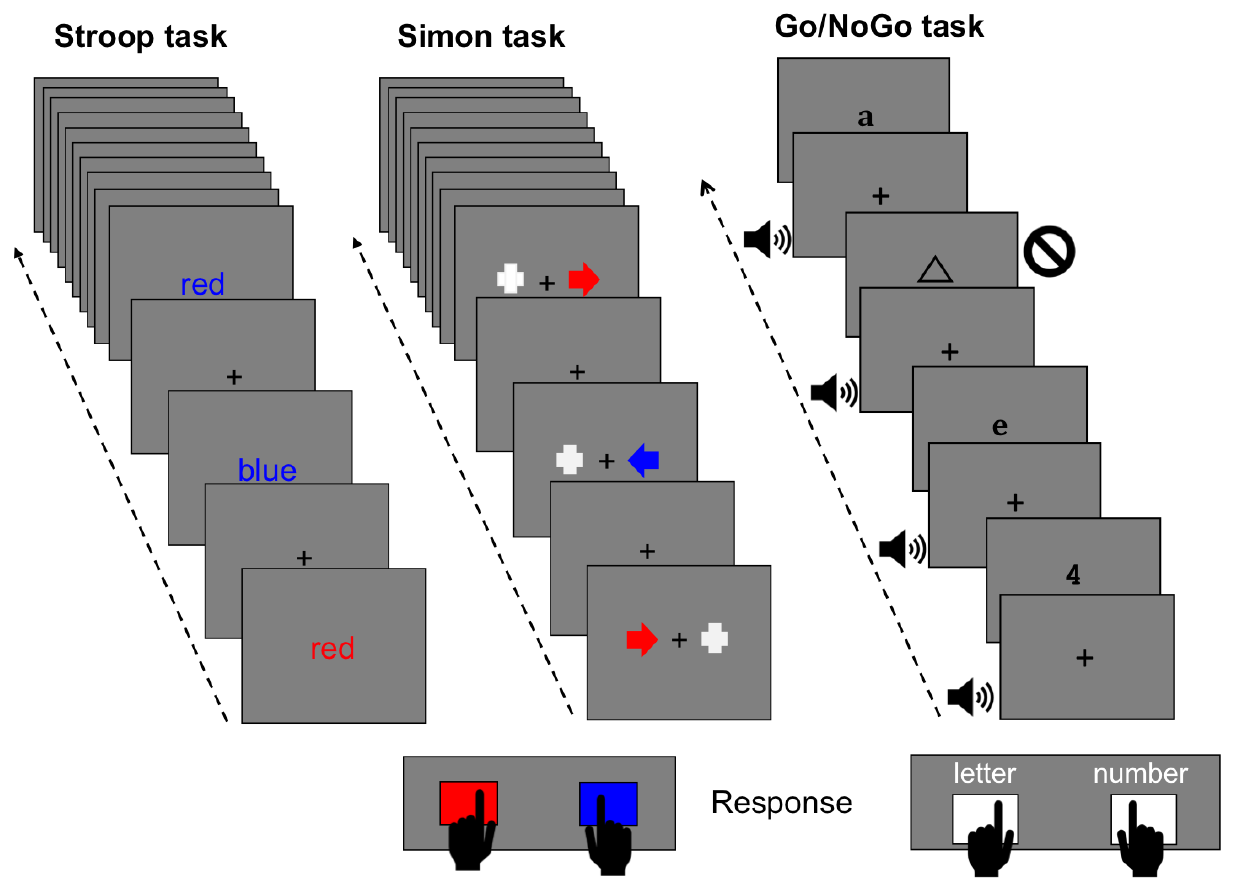
FIGURE 1 | Outline of the Stroop, Simon, and Go/NoGo tasks used in our